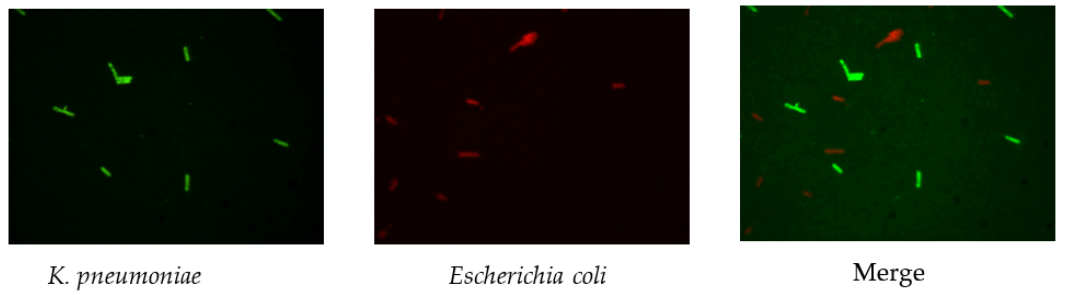
Figure 5. Simultaneous detection of E. coli and K. pneumoniae to demonstrate the specificity of the probes in